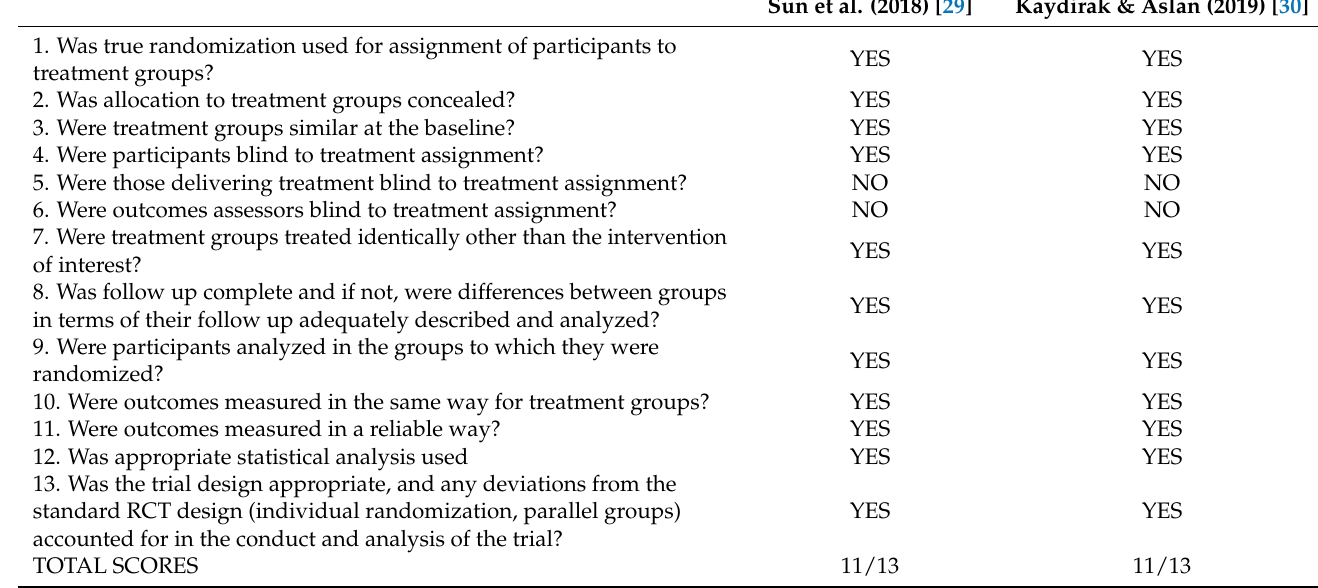
Table 2. Analysis of the ECAS studies with the JBI Checklist